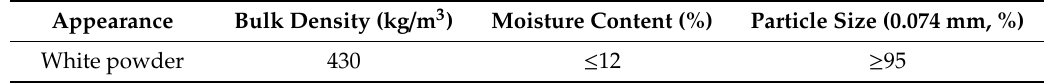
Table 6. Properties of viscosity modifying agent.